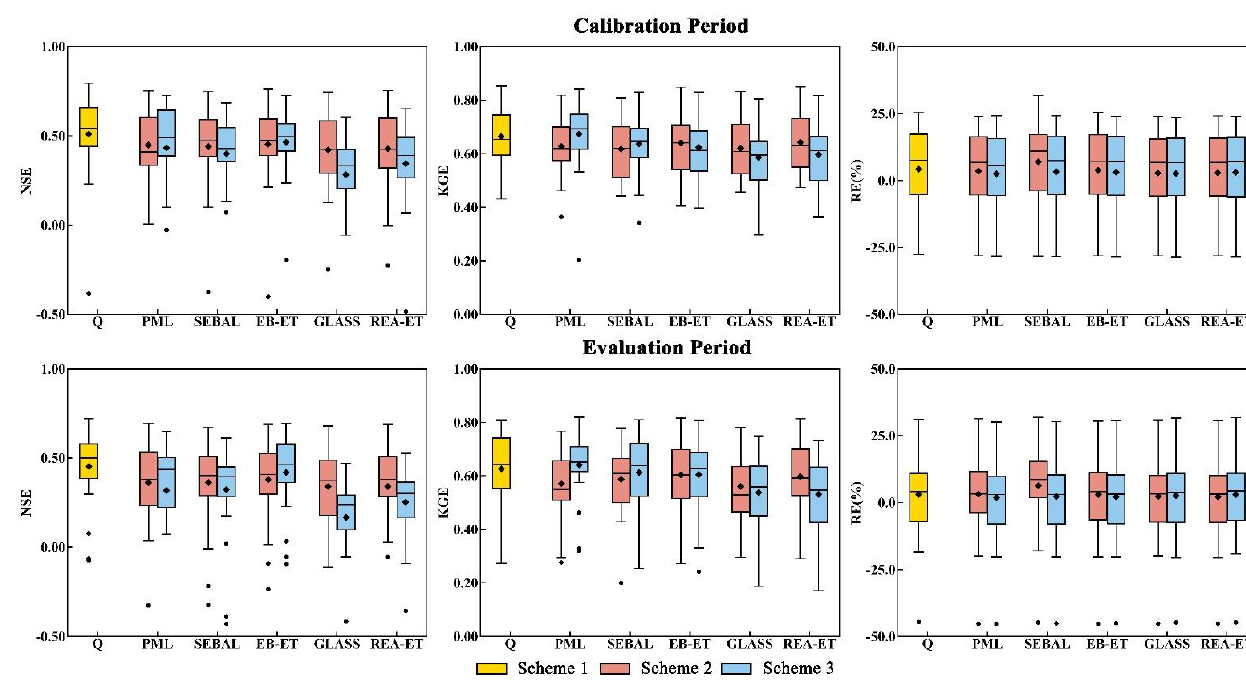
Figure 8. Statistics of model streamflow performance at the sub-basin scale for all calibration schemes. The first line of each paragraph presents the results in the calibration period, and the second line presents the results in the evaluation period.